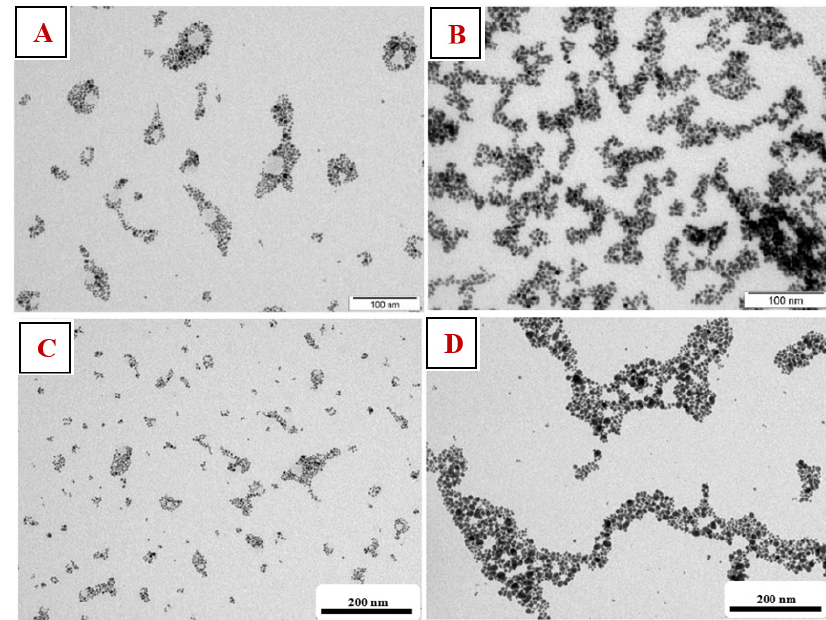
Figure 5. TEM AuNP images in PEG/TCD/H 2 O prepared with a deposition time of 300 s. ( A ) TCD/H 2 O (0.5 g/100 mL) solution and ( B ) TCD/H 2 O (1.5 g/100 mL) solution. TEM AuNP images in PEG/TCD/H 2 O at a TCD/H 2 O ratio of 0.5 g/100 mL prepared with deposition times of 100 ( C ) and 500 s ( D ).